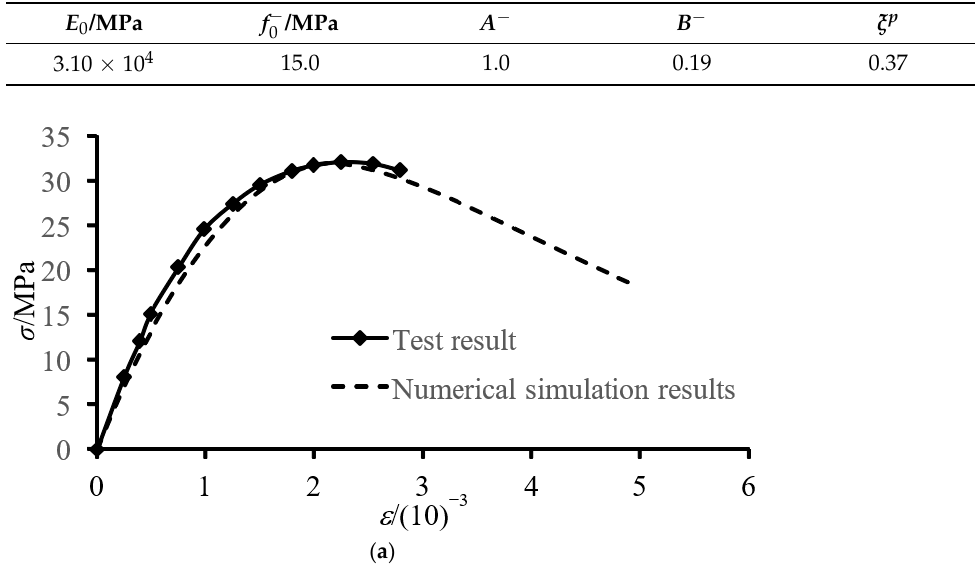
Table 3. Simulation parameters of biaxial stress test.